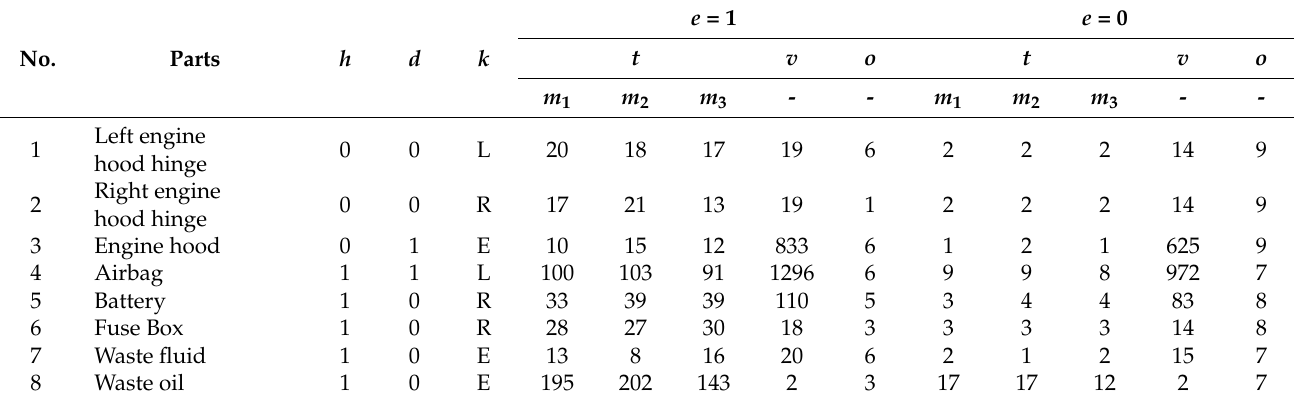
Table 2. Tasks information of the automobile